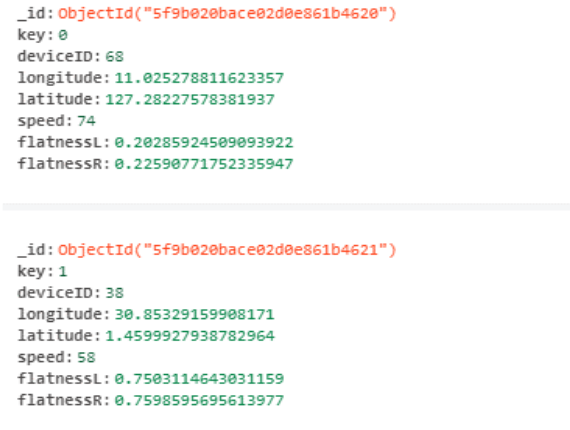
Figure 9. NoSQL Data Sample.